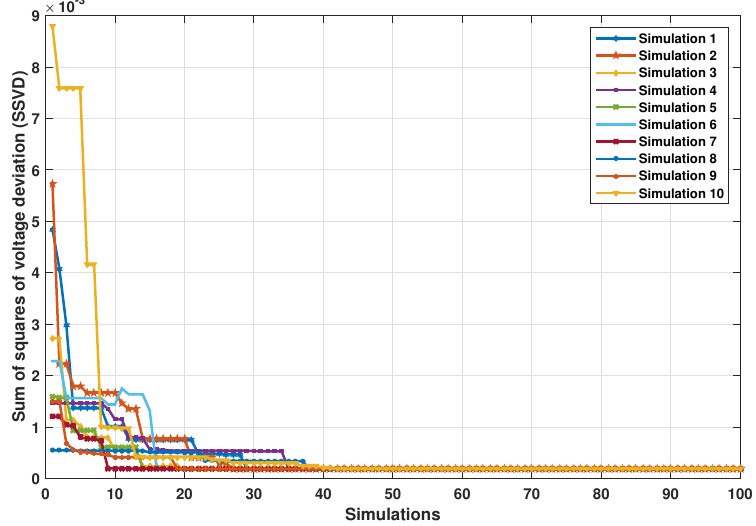
Figure 2. IEEE 15 bus system-Convergence